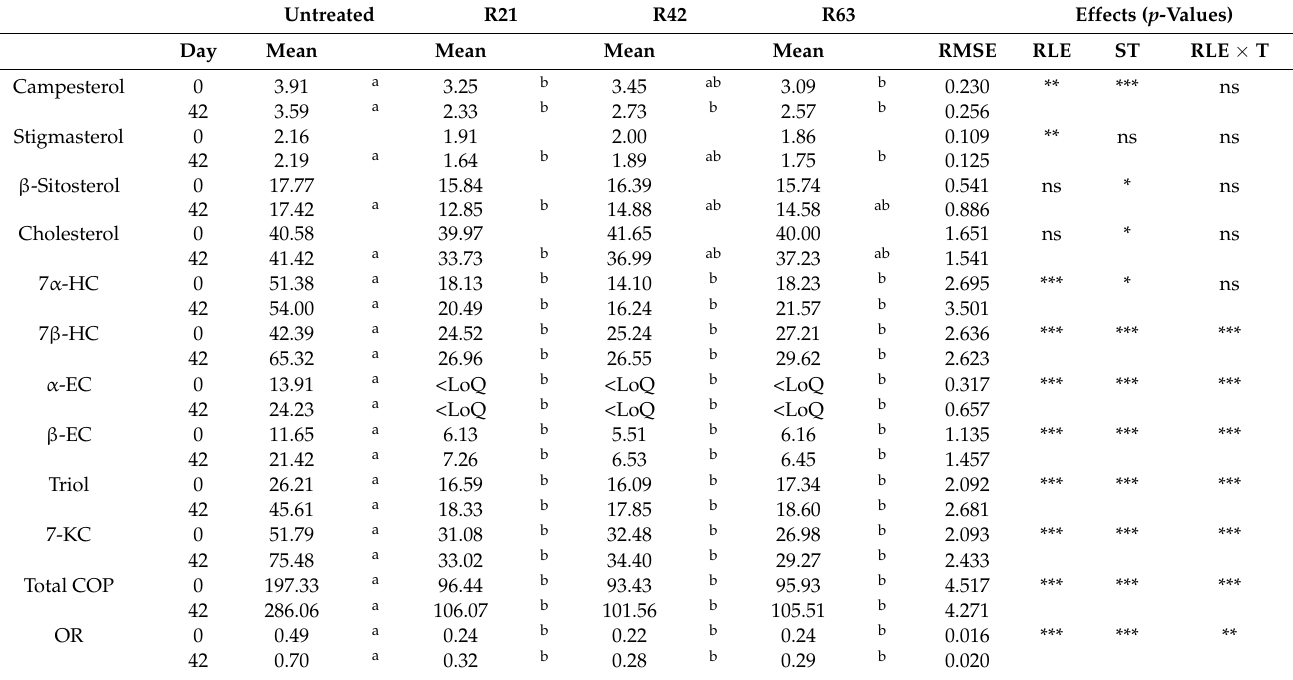
Table 6. Phytosterols (mg/100 g), cholesterol (mg/100 g), COP ( µ g/100 g) and cholesterol oxidation ratio (%) of salmon p â t é .